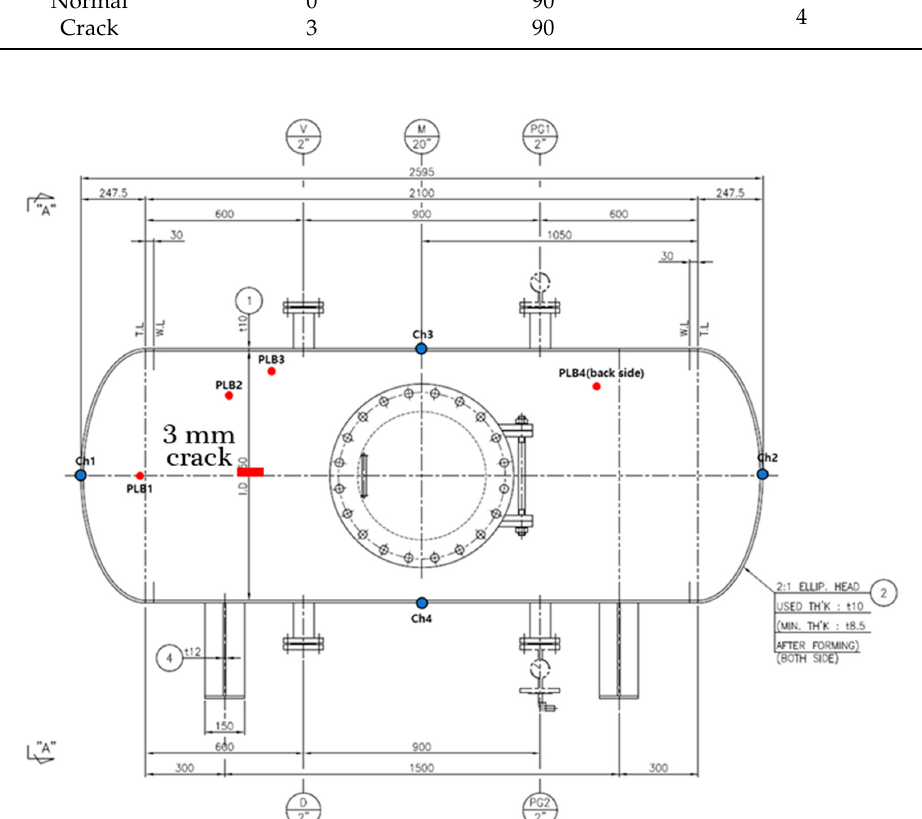
Figure 3. Geometric diagram of the pressure vessel with the specific positions of the channels and crack location.